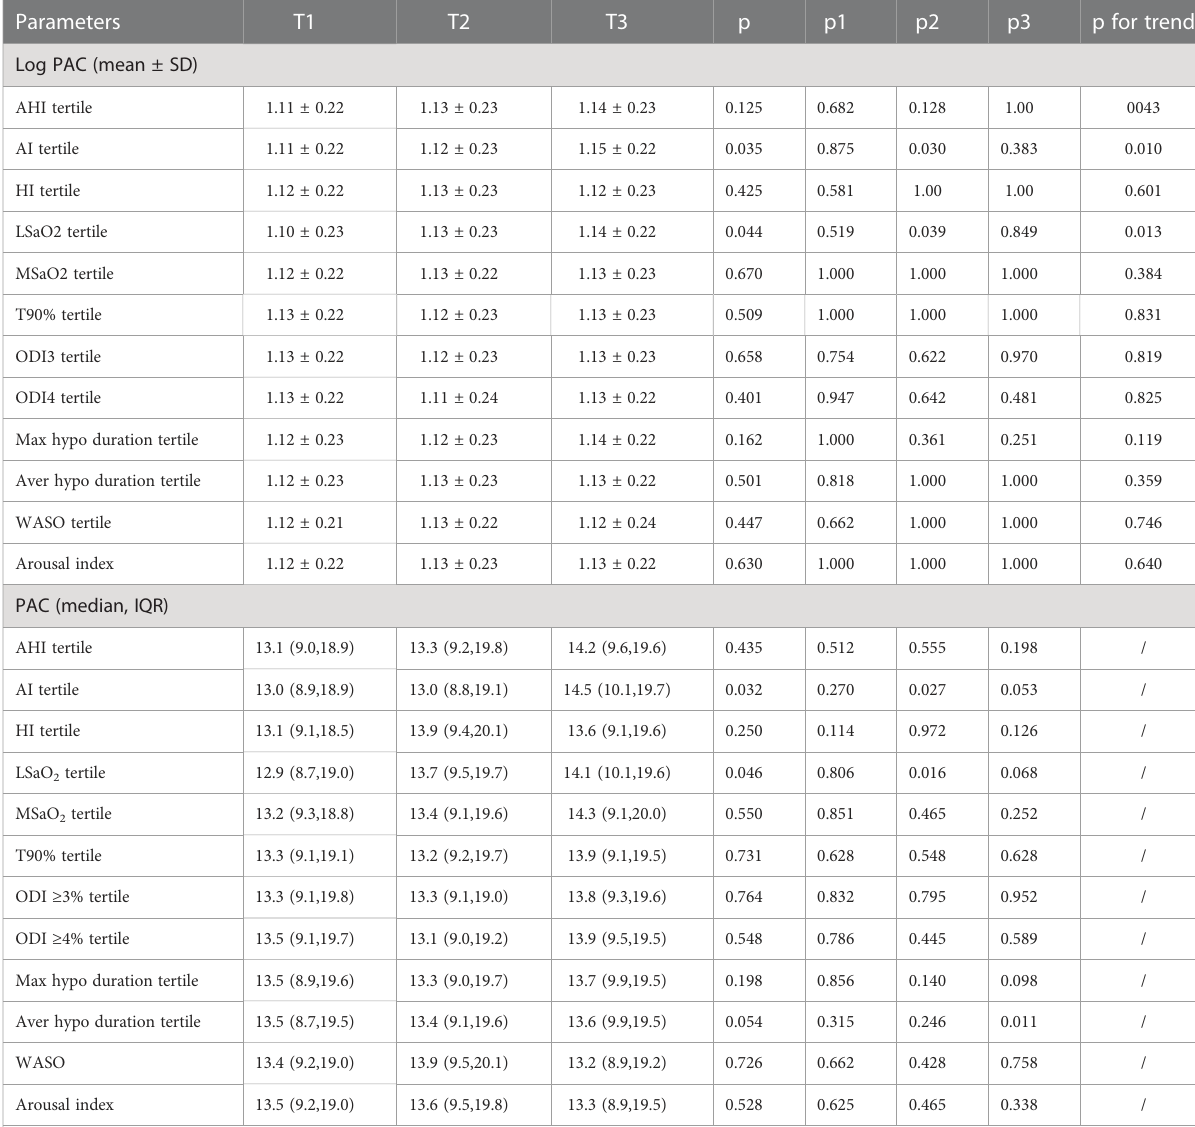
TABLE 2 Comparison of plasma aldosterone concentration by tertile of polysomnography sleep parameters in men participants with hypertension under no interfering agents with Bonferroni correction for between group comparison.